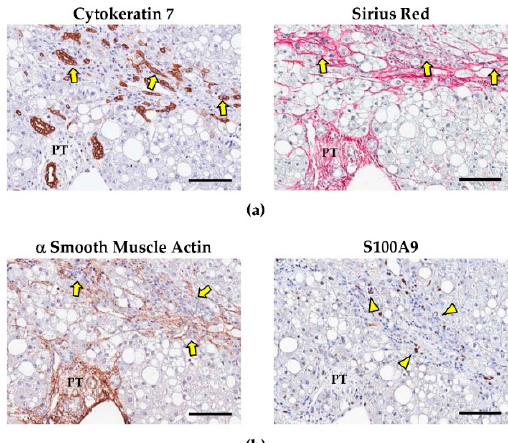
Figure 2. Ductular reaction (DR), myofibroblasts, and portal macrophages in non-alcoholic fatty liver disease (NAFLD). ( a ) As NAFLD progresses from simple steatosis to non-alcoholic steatohepatitis (NASH), a prominent DR emerges (arrows in image on the left) and is associated with portal/periportal fibrosis, as evidenced in Sirius Red stains (arrows in image on the right). ( b ) The expansion of DR is associated with the activation of ( α smooth muscle actin-positive) hepatic stellate cells and portal myofibroblasts (arrows), and the recruitment of pro-inflammatory (S100A9 + ) macrophages (arrowheads), which participate in portal/periportal fibrogenetic pathway. PT: portal tract. Scale bars: 100 μ m. Images obtained from liver biopsies of patients affected by NAFLD.